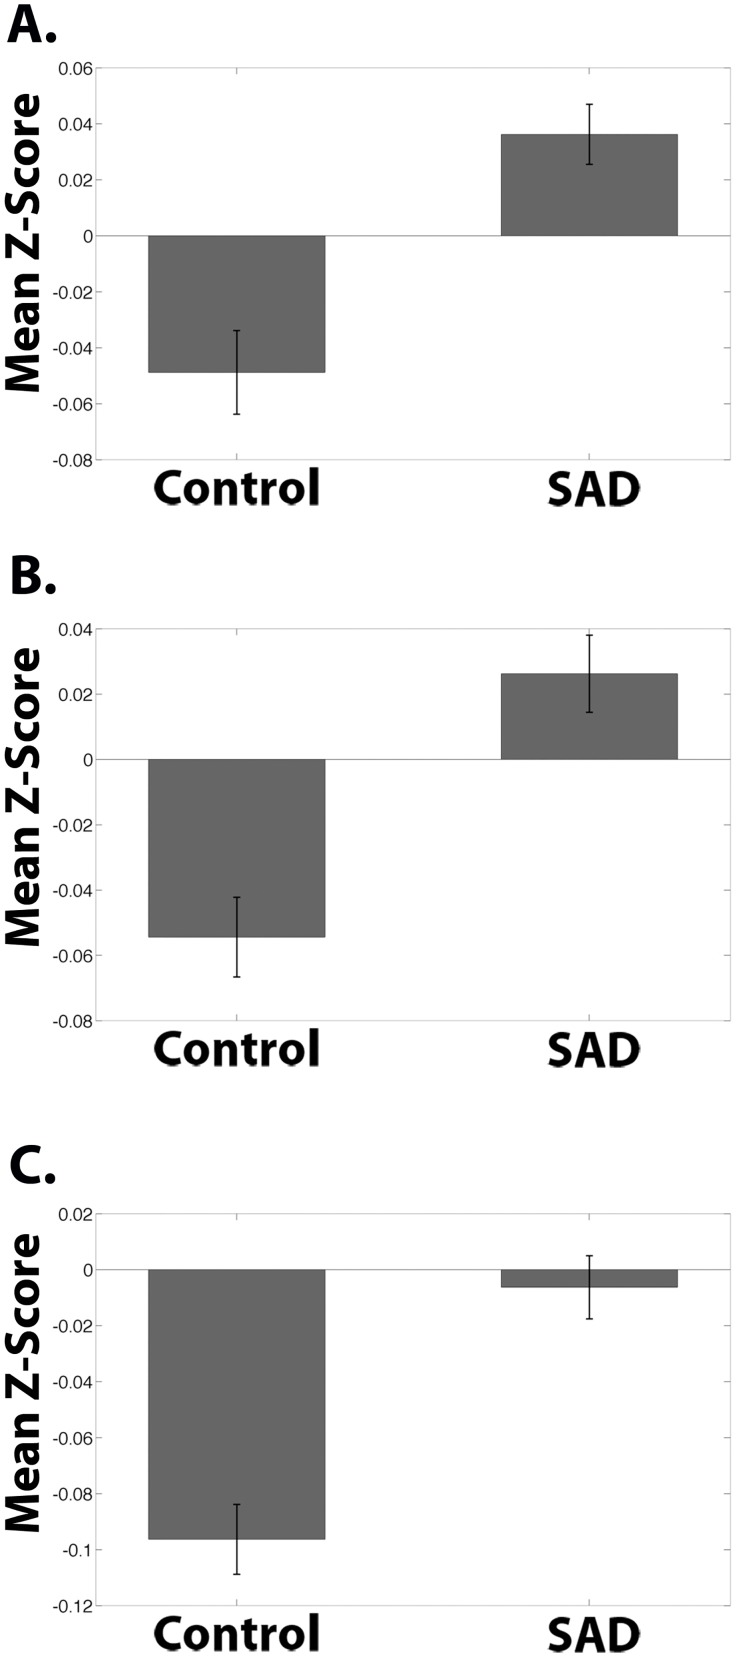
Ventromedial Prefrontal Cortex Seed Functional Connectivity Network Z-Scores of SAD > Control.Mean Fisher transformed correlation values for resting-state connectivity for clusters from Fig 6C showing significant difference for SAD group > Control group with ventromedial prefrontal cortex seed from Fig 6A. Bars represent the mean connectivity for each group for the clusters from Fig 6C. (A) Peak voxel Cluster 1 (MNI coordinates): (6, -42, 60). One-sample t-test relative to 0: Control: p = .003; SAD: p = .001. (B) Peak voxel Cluster 2 (MNI coordinates): (20, -50, 6). One-sample t-test relative to 0: Control: p < .0001; SAD: p .031. (C) Peak voxel Cluster 3 (MNI coordinates): (-50, -56, -4). One-sample t-test relative to 0: Control: p < .0001; SAD: p = .58. Error bars represent standard errors.